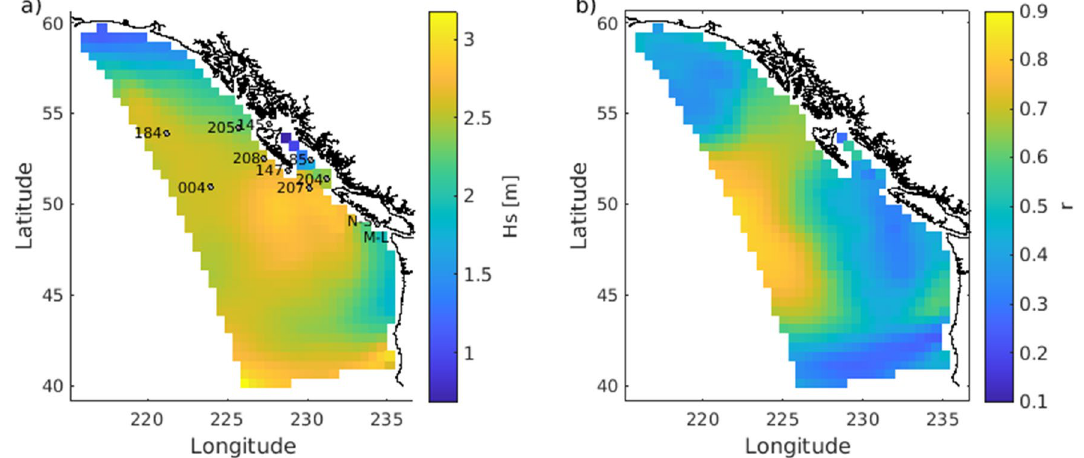
Figure 5. Example forecast output for March 22, 2020 00h UTC of ( a ) significant wave height H s and ( b ) crest- trough correlation r . These model output fields form the basis of a rogue wave risk prediction. Grey markers in ( a ) are locations of buoys utilized in this study. M-L and N-S marking the location of the coastal MarineLabs and Nearshore buoys, respectively and the numbered markers are the buoys from Fisheries and Oceans Canada where the complete names are the numbers preceded by a ‘C46’